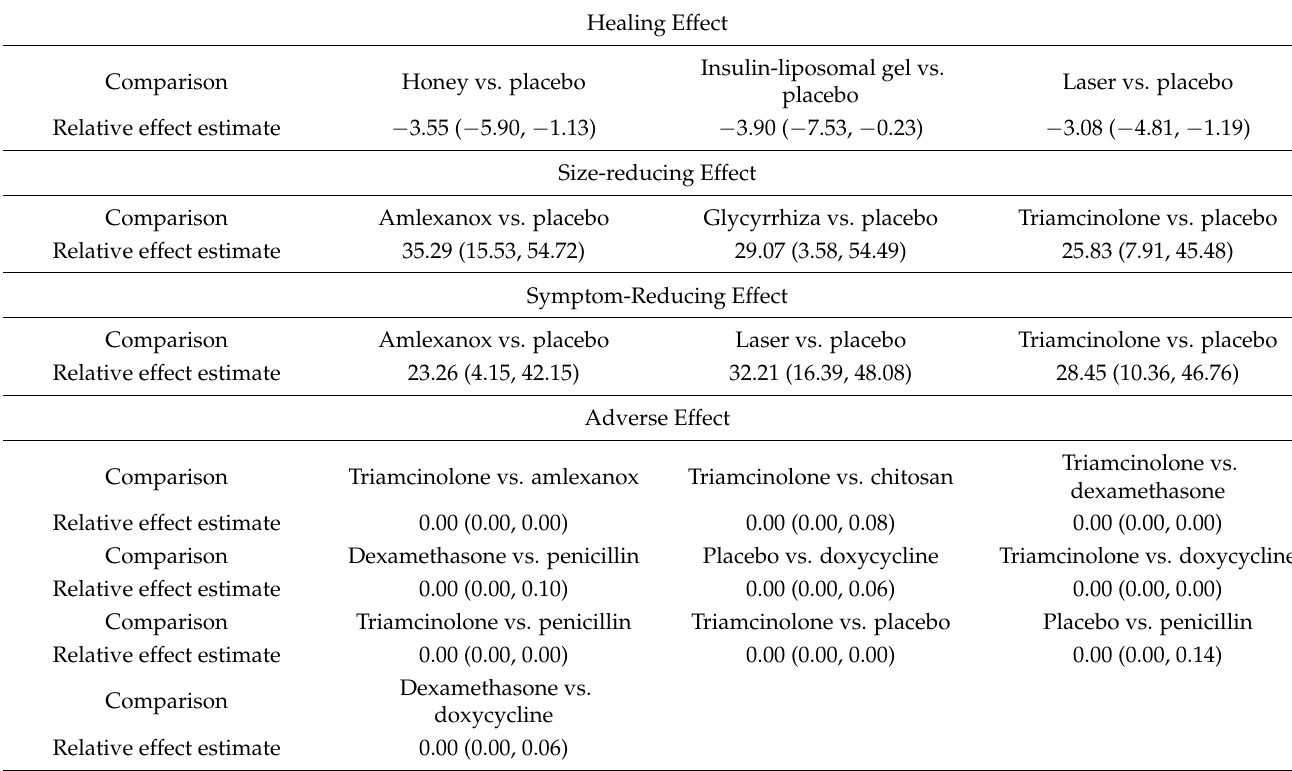
Table 1. Significantly different estimates for healing